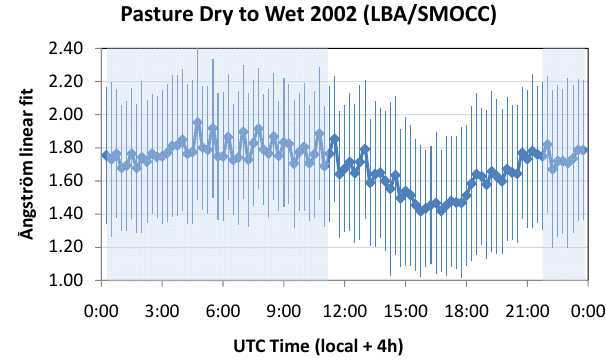
˚Angstr¨om exponents calcu- Fig. 8. Average diurnal cycle of the ˚a lin abs lated for Pasture Dry to Wet 2002 (SMOCC). Bars represent statis- tical standard deviations. Shaded areas represent nighttime